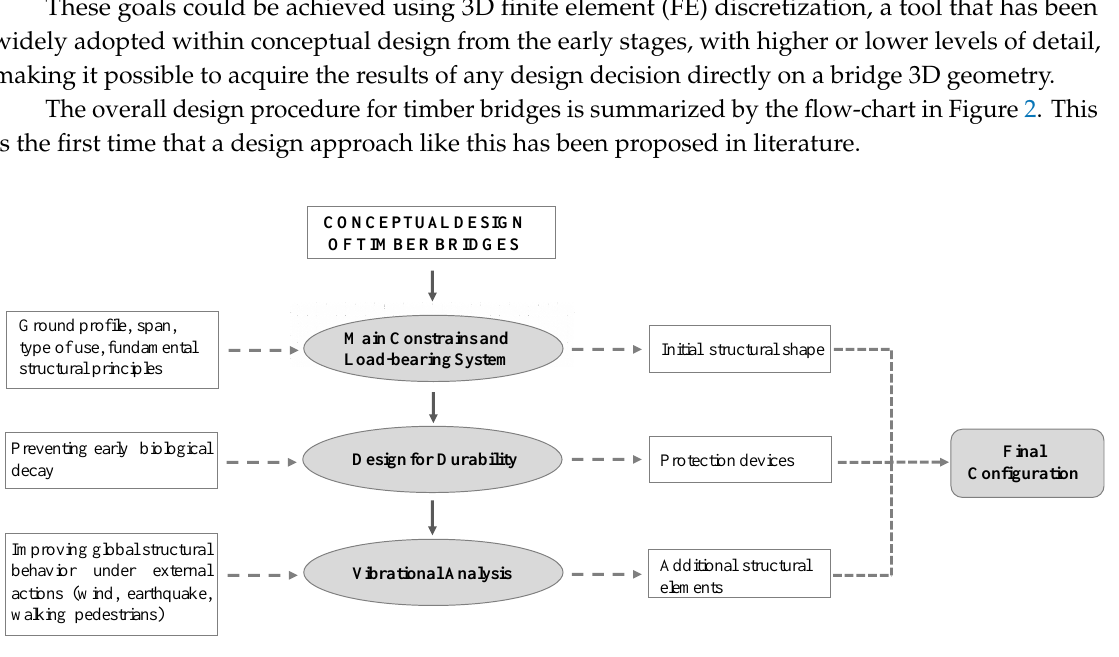
Figure 1. Influence of boundary conditions on the choice of a bridge structural system. “Concours de architecture presso l’ É cole des Ponts et Chauss é es”, 1818. Student: Marie Fortun è de Verg é s [6] (1. Simple girder; 2 and 3. girder supported by compressed struts; 4. girder reinforced by an additional. beam; 5 and 6 girder supported by compressed and branched struts; 7 and 8. girder supported by a multilayer arch connected through orthogonal wood elements; 9 and 10. More complex schemes).